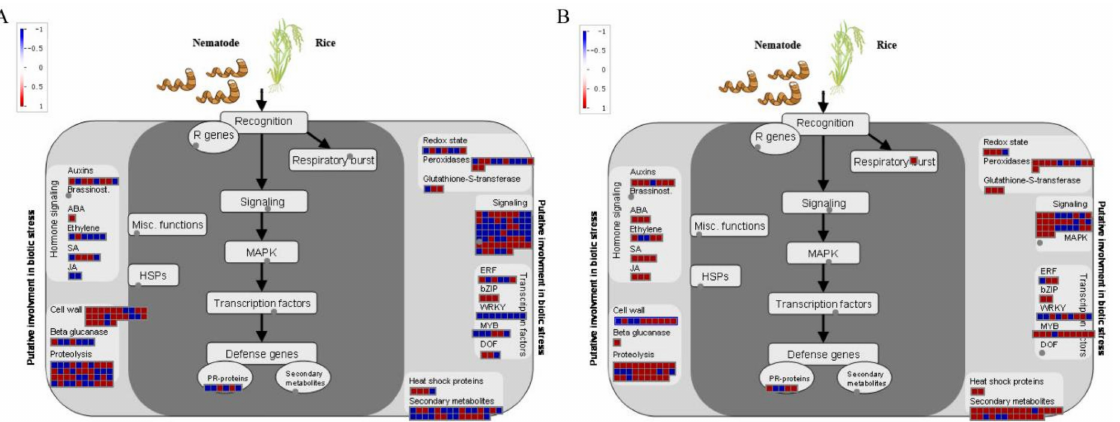
Figure 4. DEG analysis of Nipponbare rice roots infected by M. incognita using MapMan ( A ) 6dpi; ( B )